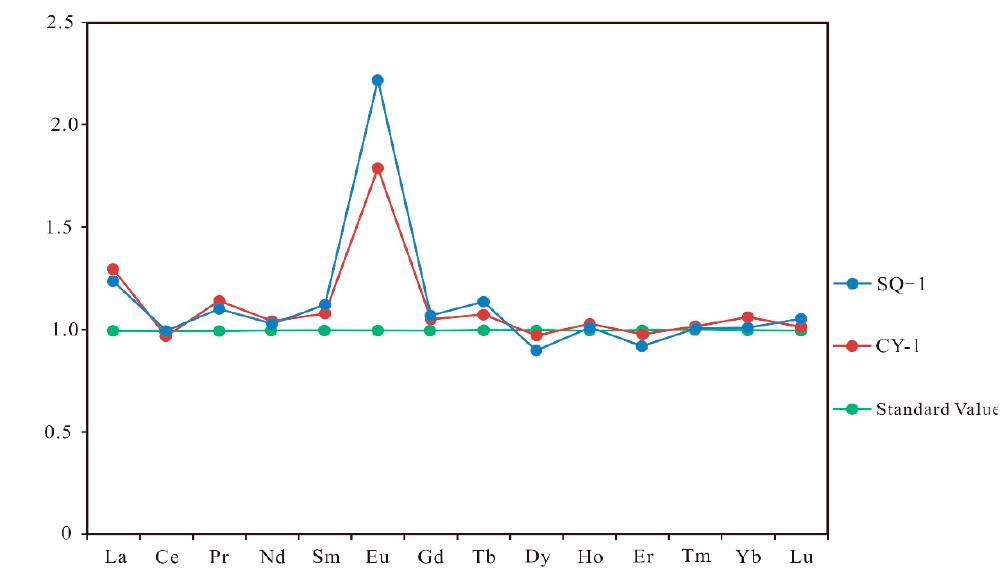
Figure 6. North American Shale composite (NASC)-normalized rare earth elements (REE) distribution patterns for the samples from SQ-1 and CY-1.